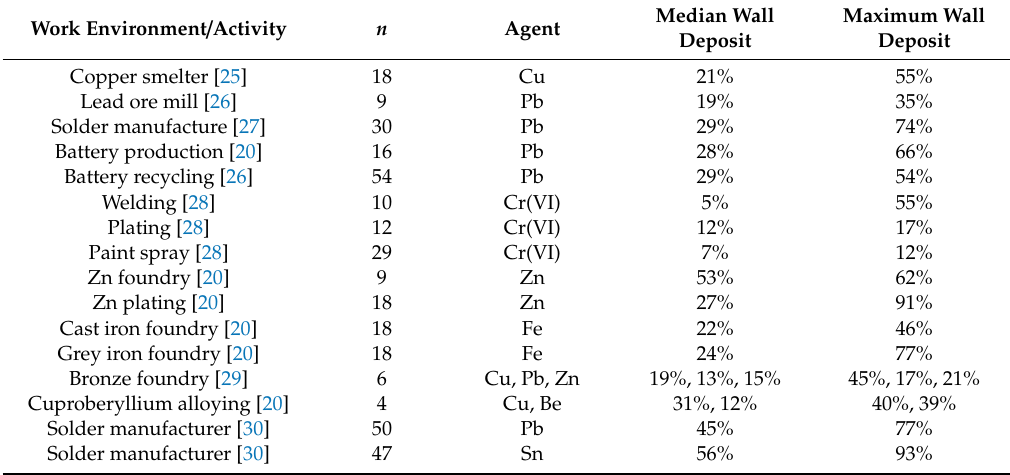
Table 1. Summary of findings of internal wall deposits as a percentage of total catch (filter plus walls) in field samples using the 37-mm CFC